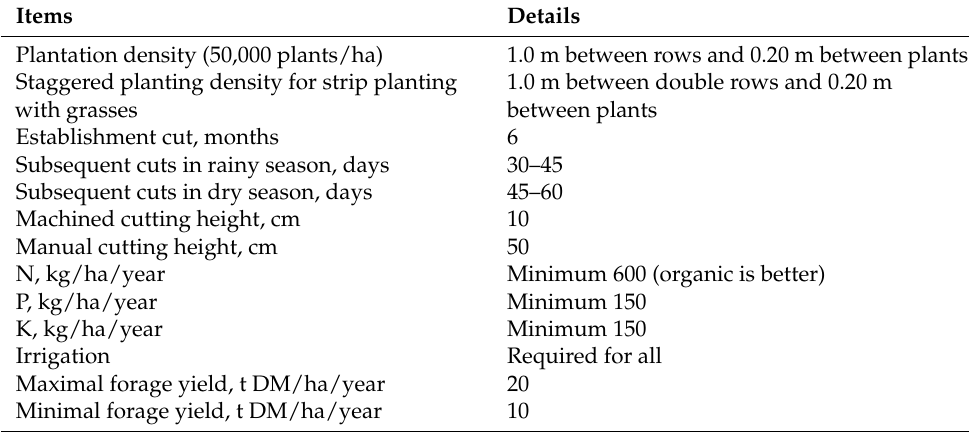
Table 1. Summary of Hibiscus rosa-sinensis hyperproducer forage technology. DM: dry